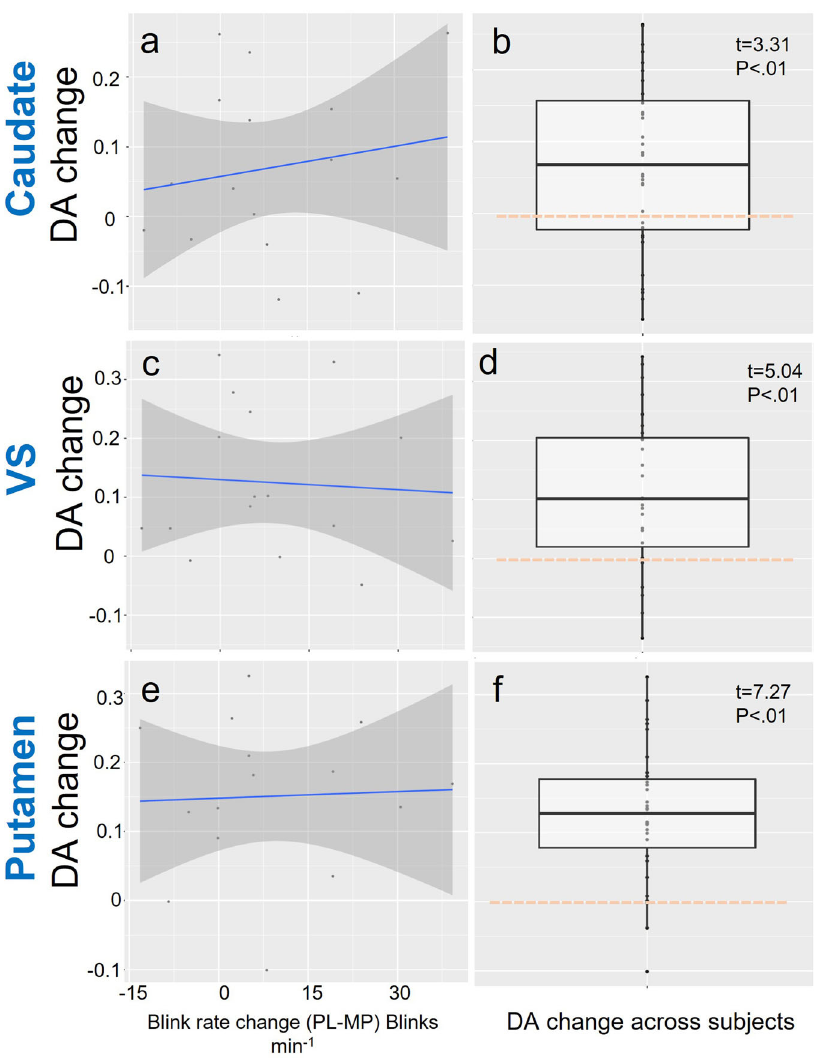
Fig. 6 MP-induced changes in striatal DA. b , d , f MP-induced changes in striatal DA (D2R BPnd PL – D2R BPnd MP) ( n = 32) in caudate, VS, and putamen respectively and, a , c , e its association with MP-induced changes in EBR (PL-MP) ( n = 16) in caudate, VS, and putamen respectively. MP -induced changes in DA were signi fi cant in all three ROIs as expected. MP-induced DA changes were not correlated with MP-induced EBR changes. Shaded areas in the fi gures a , c , e indicate 95% Con fi dence Interval (CI). Points represent each value from each participant. Box plots in the fi gures b , d , f the median (line in the middle of the box), interquartile range (IQR) shown as the frames of the box (bottom and top of the box are the 25th (Q1) and 75th (Q3) percentiles), and the extending lines end at the values of Q1 − 1.5*IQR and Q3 + 1.5*IQR respectively. Points out of the margins are potential outliers. Orange dashed lines are located at the y -axis 0